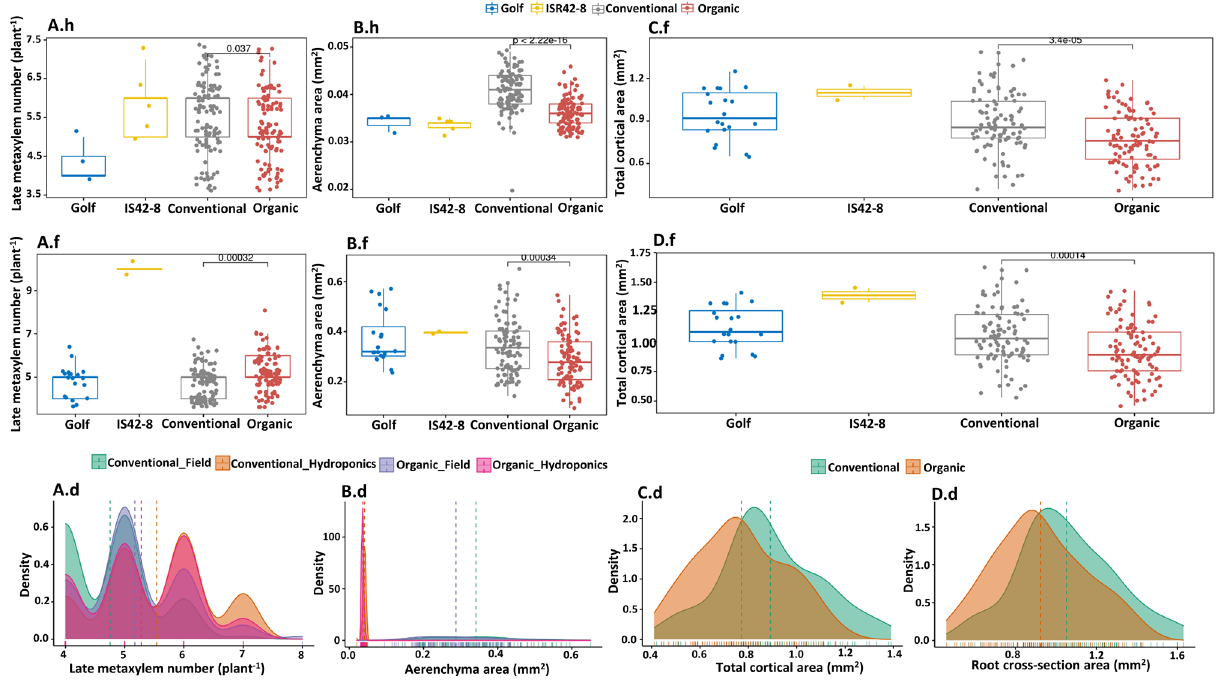
Figure 2. Significantly variant root anatomical traits. Boxplots illustrate the overall distribution of observed data points for the parents Golf and ISR 42-8 as well as for the conventional (CCS) and organic (OCS) lines. ( A ) –Late metaxylem number (LMN)—the sum of all roots harvested and expressed by plant −1 , illustrated for all four groups. A.h—Late metaxylem number measured in the hydroponic experiment; A.f—field experiment; A.d—distribution histogram for late metaxylem number in both field and hydroponic experiment for CCS and OCS adapted lines. ( B ) — Aerenchyma area (AA). Data available for hydroponics (B.h), field (B.f), and distribution of the aerenchyma area illustrated in ( B.d ). ( C.f )—Total cortical area (TCA) from the field; ( D.f )— Root cross-section area (RA) from the field, distribution of the total cortical area and root cross-section area illustrated in C.d and D.d,